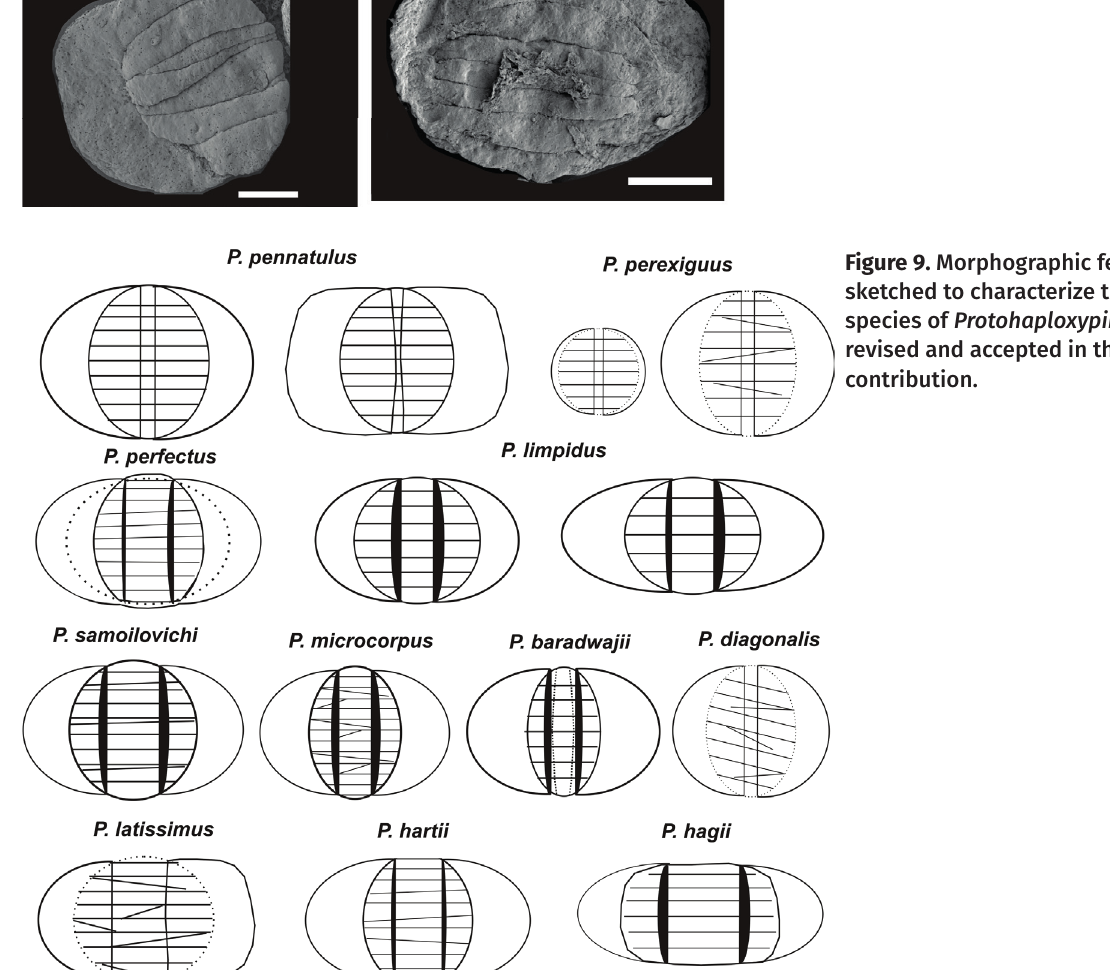
Figure 9. Morphographic features sketched to characterize the species of Protohaploxypinus revised and accepted in this